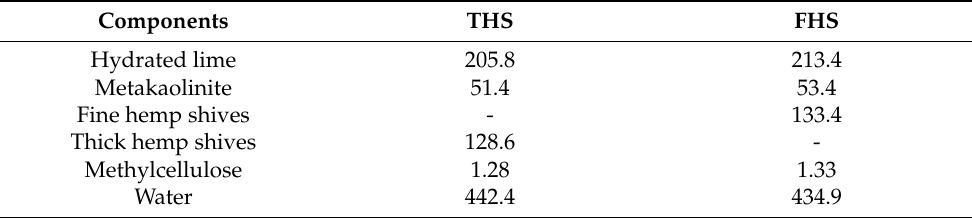
Figure 1. Hemp shives used in the investigation: fine shives ( a ) and thick shives ( b ). Table 1. Components of composites in kg per 1 m 3 of the mixture.